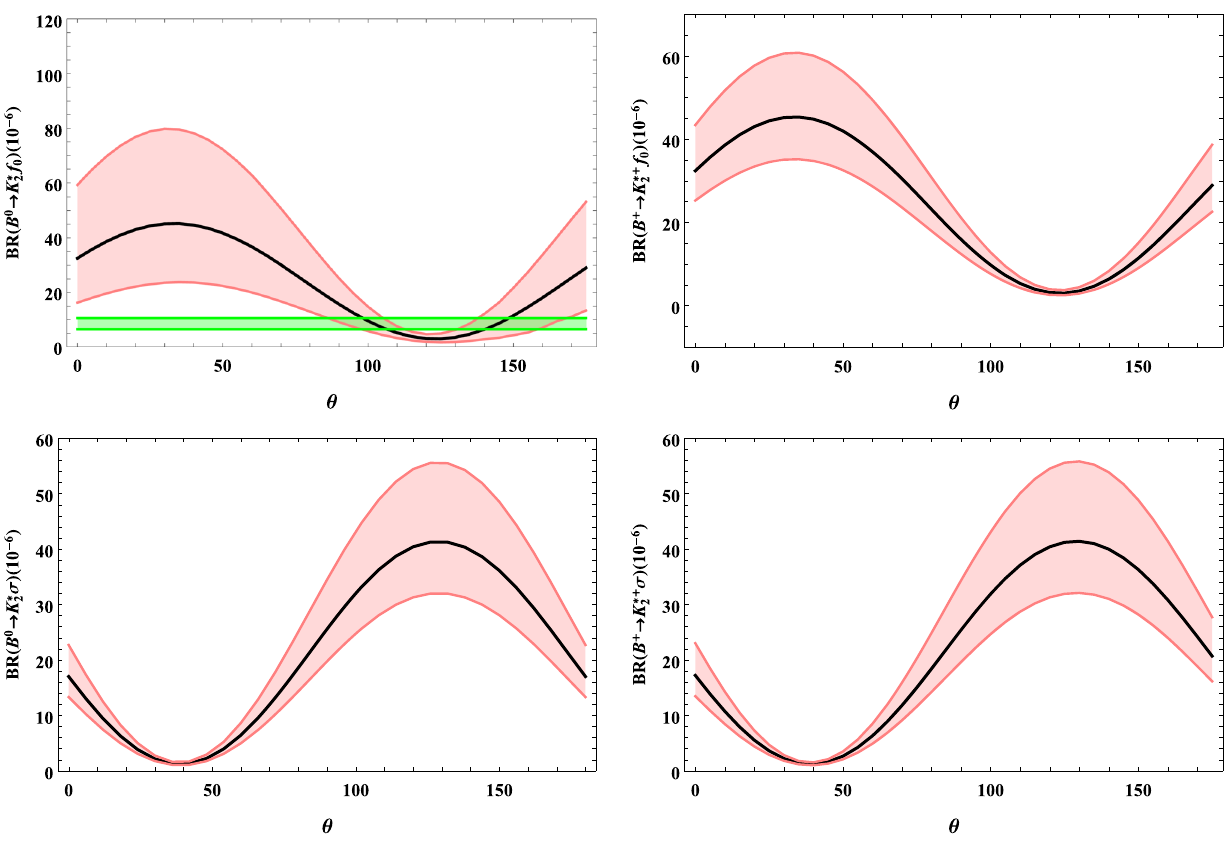
σ with variant of the mixing angle θ . The black lines are the center values, and the f 0 and B → K ∗ 2 2